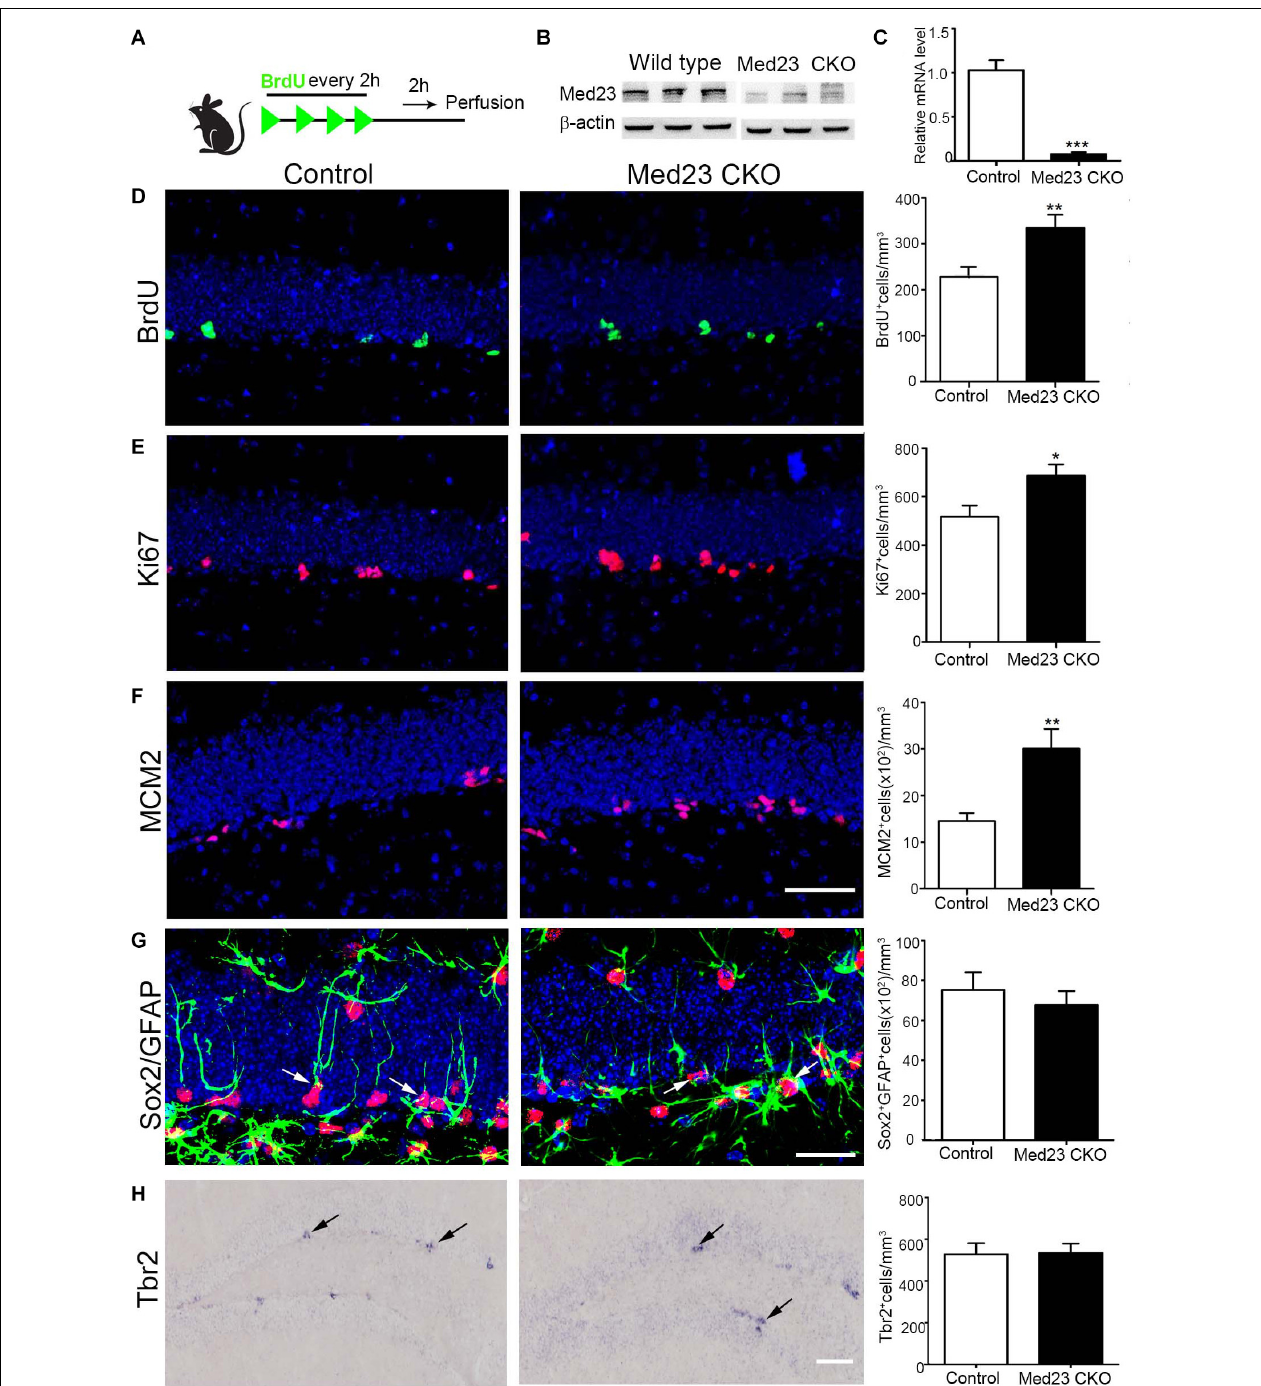
FIGURE 1 | Increased proliferation of Med23-deficient hippocampal NSCs in vivo . (A) Schematic representation of BrdU injection. (B) Western blot of hippocampal tissues of Med23 CKO mice relative to wild type littermates. N = 3 for each. (C) qPCR data showing the Med23 mRNA levels in the primary neurospheres of control and Med23 CKO. Neurospheres from six control and three Med23CKO mice was included. (D) Distribution and quantification of BrdU + cells in the SGZ of control and Med23 CKO. Seven control mice and six Med23 CKO mice were included. (E) Distribution and quantification of Ki67 + cells in the SGZ of control and Med23 CKO mice. N = 8 mice in control and seven mice in Med23 CKO groups. (F) Distribution and quantification of MCM2 + cells in the SGZ of control and Med23 CKO mice. N = 5 mice in each group. Scale bar = 50 µ m (D–F) . (G) Distribution and quantification of Sox2 + /GFAP + cells (arrows) in the SGZ of control and Med23 CKO. N = 5 mice in control and six mice Med23 CKO groups. Scale bar = 25 µ m. (H) Distribution and quantification of Tbr2 + cells (arrows) in the SGZ of control and Med23 CKO mice. N = 4 mice in each group. Scale bar = 100 µ m. Data are plotted as the mean ± SEM. Student t -test, * p < 0.05, ** p < 0.01, *** p < 0.001.